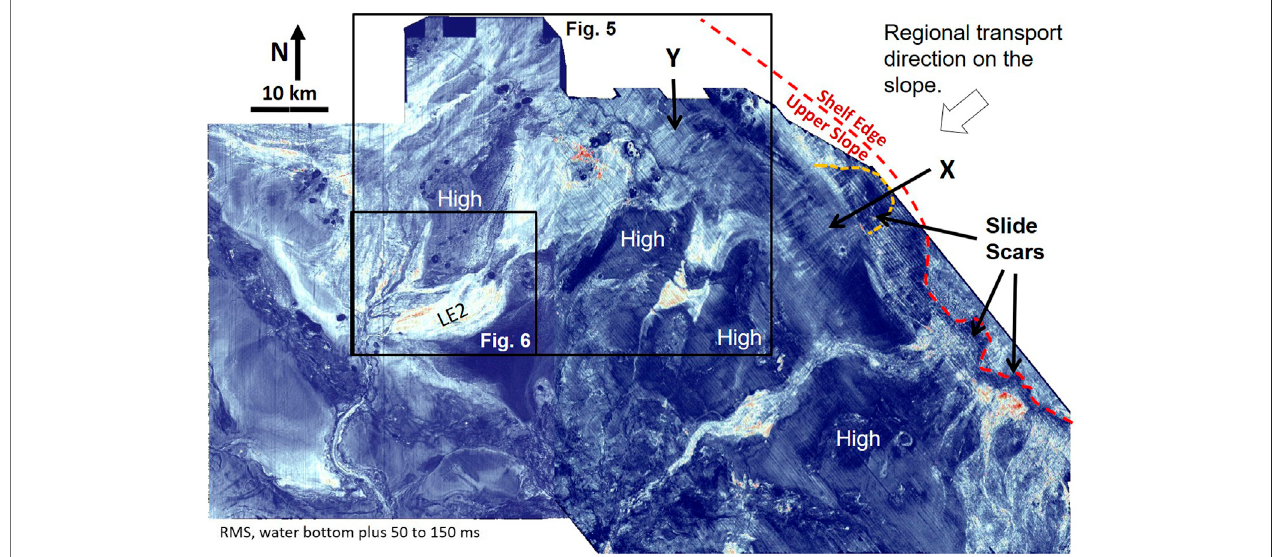
FIGURE 4 | A Root Mean Squared (RMS) amplitude extraction from 3D re fl ection seismic volumes on the middle to upper slope, off shore Nigeria (location in Figure 1 ). The image is calculated from the interval between 50 and 150 ms below seabed (approximately 100 m of sediment). Sediment transport is from northeast to southwest and water depth increases to the southwest. High RMS values are displayed as white to orange colors. The approximate position of the shelf edge is representedbyareddashedline.Theedgesoflargeslidecomplexesattheshelfedgeareindicatedbyscallop-shapedindentationsintheshelfedge.Theedgeofa large slide scar complex on the upper slope is indicated by an orange dashed line. In fl uential structural highs are annotated (High). The locations of panels 5, 6 are indicated. The location of LE2 is labeled as are the locations of areas X and Y (discussed in the text).